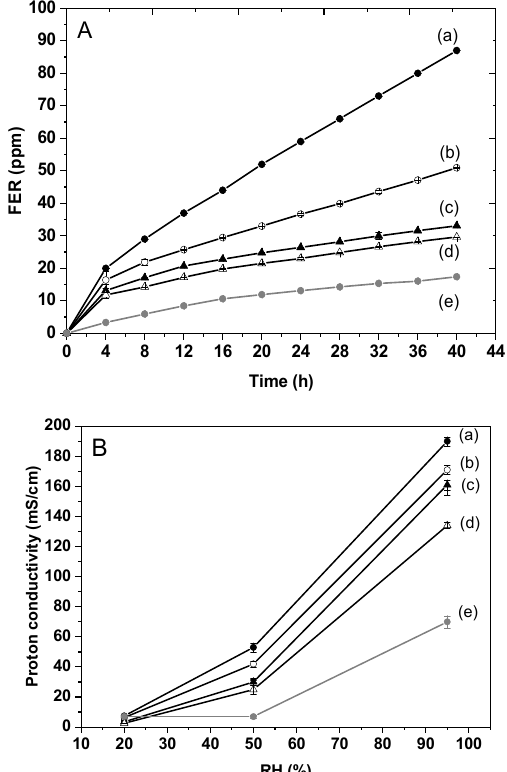
Figure 7. Fluoride Emission Rate (FER) as a function of time ( A ) and in-plane proton conductivity at 90 °C as a function relative humidity ( B ) of composite membranes loaded with different amounts of CeO 2 @HNT-NH 2 corresponding to the following Ce/HSO 3- ratios: 1% (b), 2% (c), 2.5% (d), 5% (e) and comparison with the pristine Aquivion ® membrane (a). Table 2. Mechanical properties of reference membrane Aquivion ® 830EW and composite